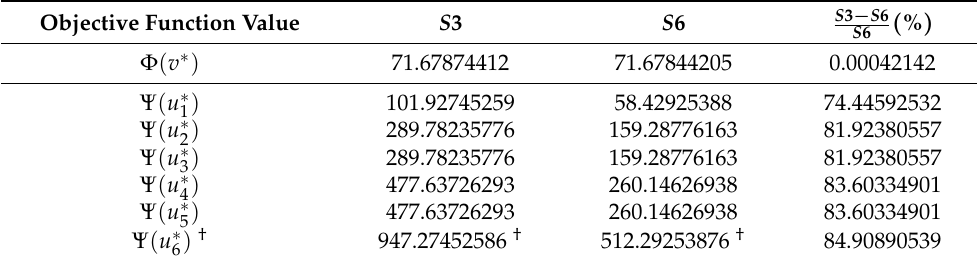
Table 7. Performance analysis: S 3 vs. S 6.